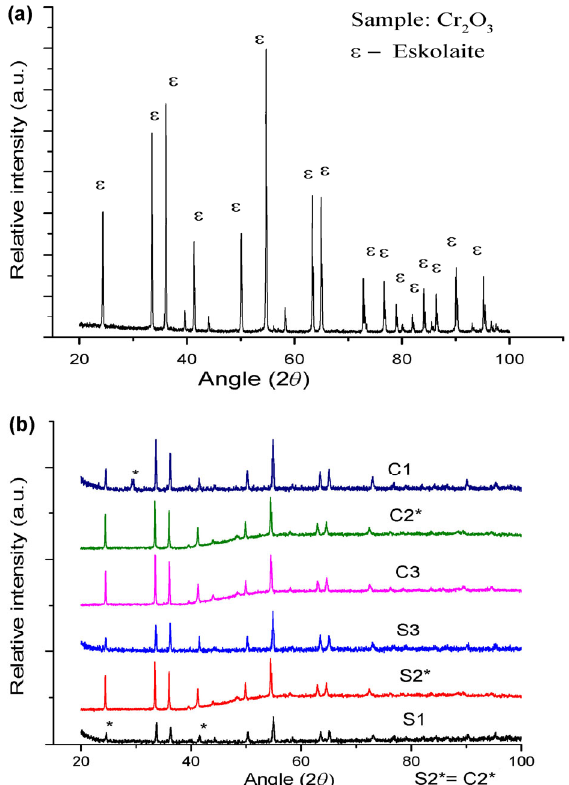
Fig. 6 X-ray diffraction of (a) chromia powder and (b) chromia coating at five parametric variations.